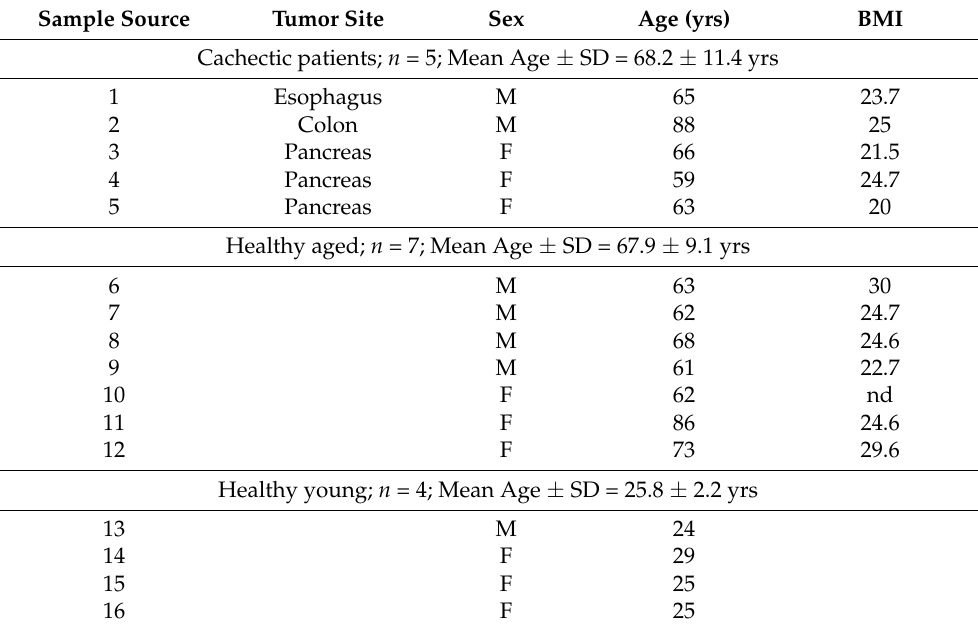
Table 1. Human subjects providing samples for immunohistochemistry.